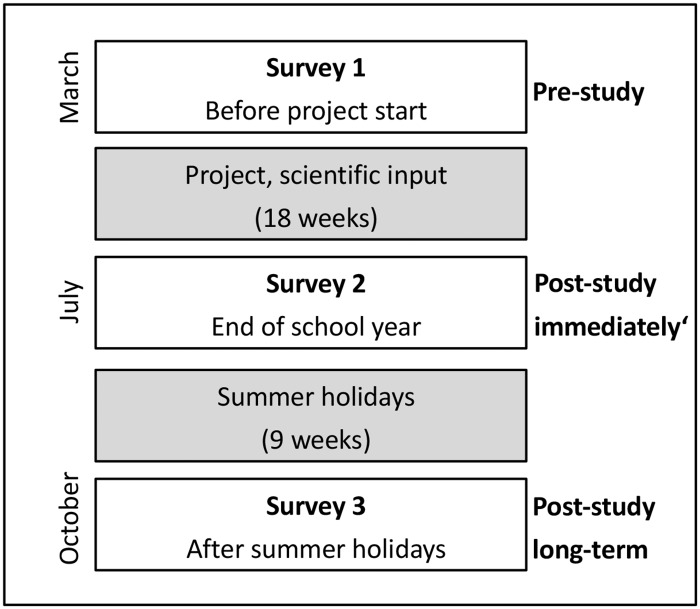
Study design.Schematic overview of the three repeated surveys.